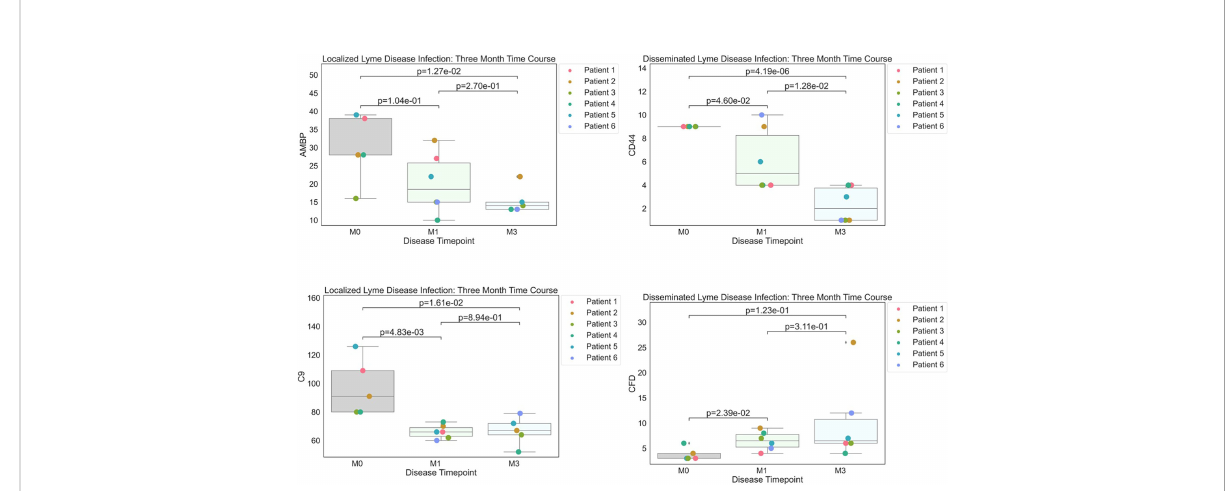
FIGURE 2 Strip plots of differentially expressed proteins between primary acute infection and recovery in Lyme disease. Serum samples from LD patients were assessed by the dHSP platform. Differentially expressed proteins were identi fi ed in a combined dataset of acute infection and convalescent time points. Patients with statistically signi fi cant proteins were de fi ned with p value ¾= 0.05. Localized Lyme disease infections were statistically signi fi cant across time points for AMBP and C9. CD44 was statistically signi fi cant across time points in disseminated Lyme Disease infections, however, CFD was statistically signi fi cant by month 1.